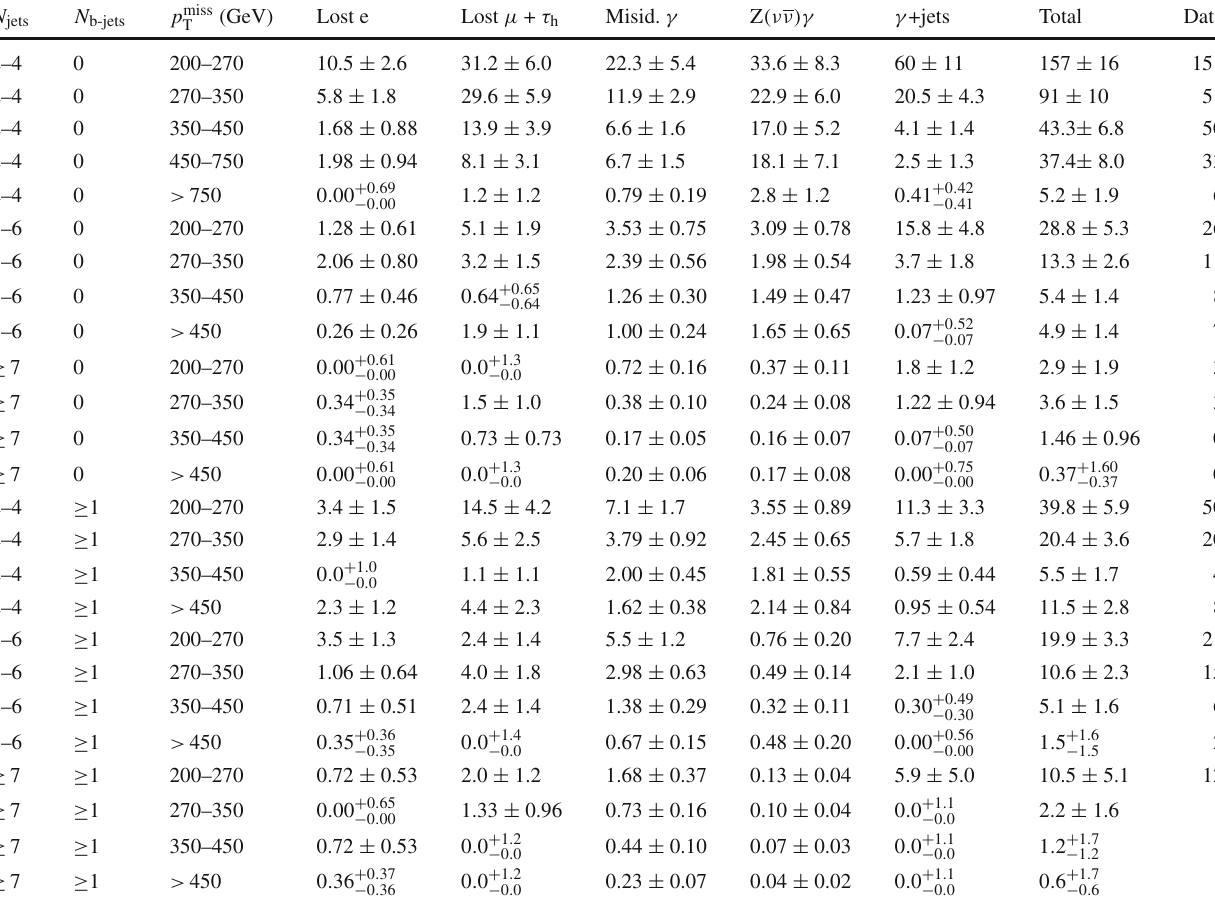
Table 1 Predicted and observed event yields for each of the 25 exclusive signal